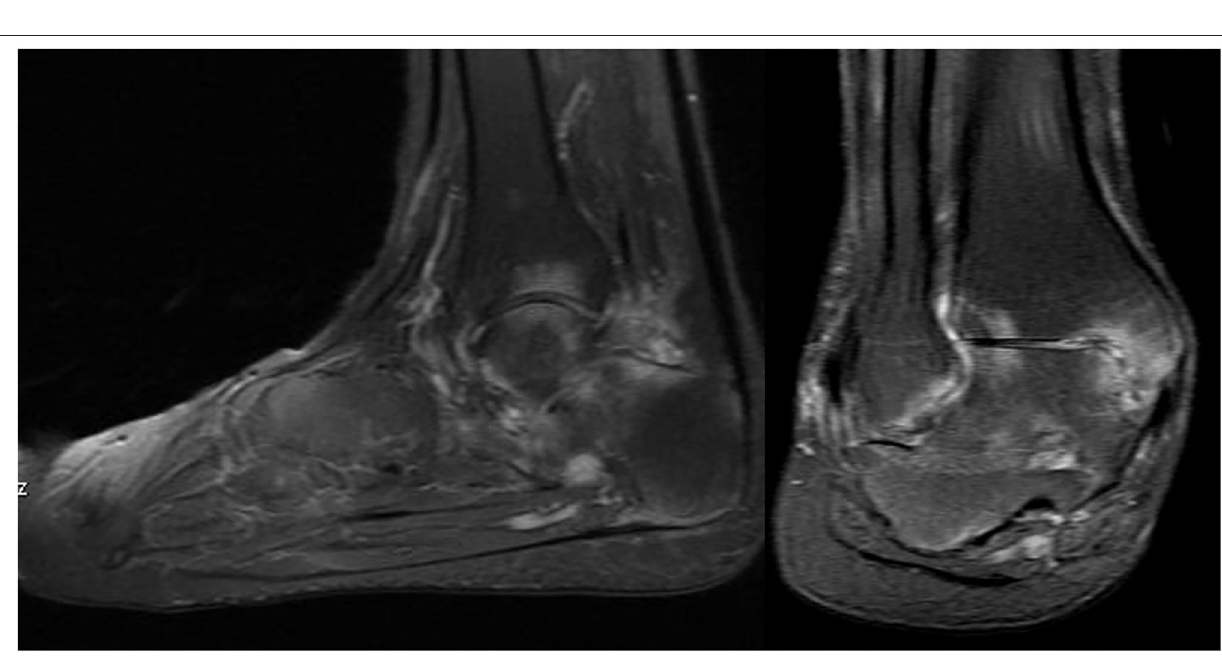
parameters of classification and interpretation of tarsitis (39). As a result, the Spondyloarthritis Tarsal Radiographic Index (SpA- TRI) has good sensitivity and specificity to evaluate structural but no inflammatory changes (39,